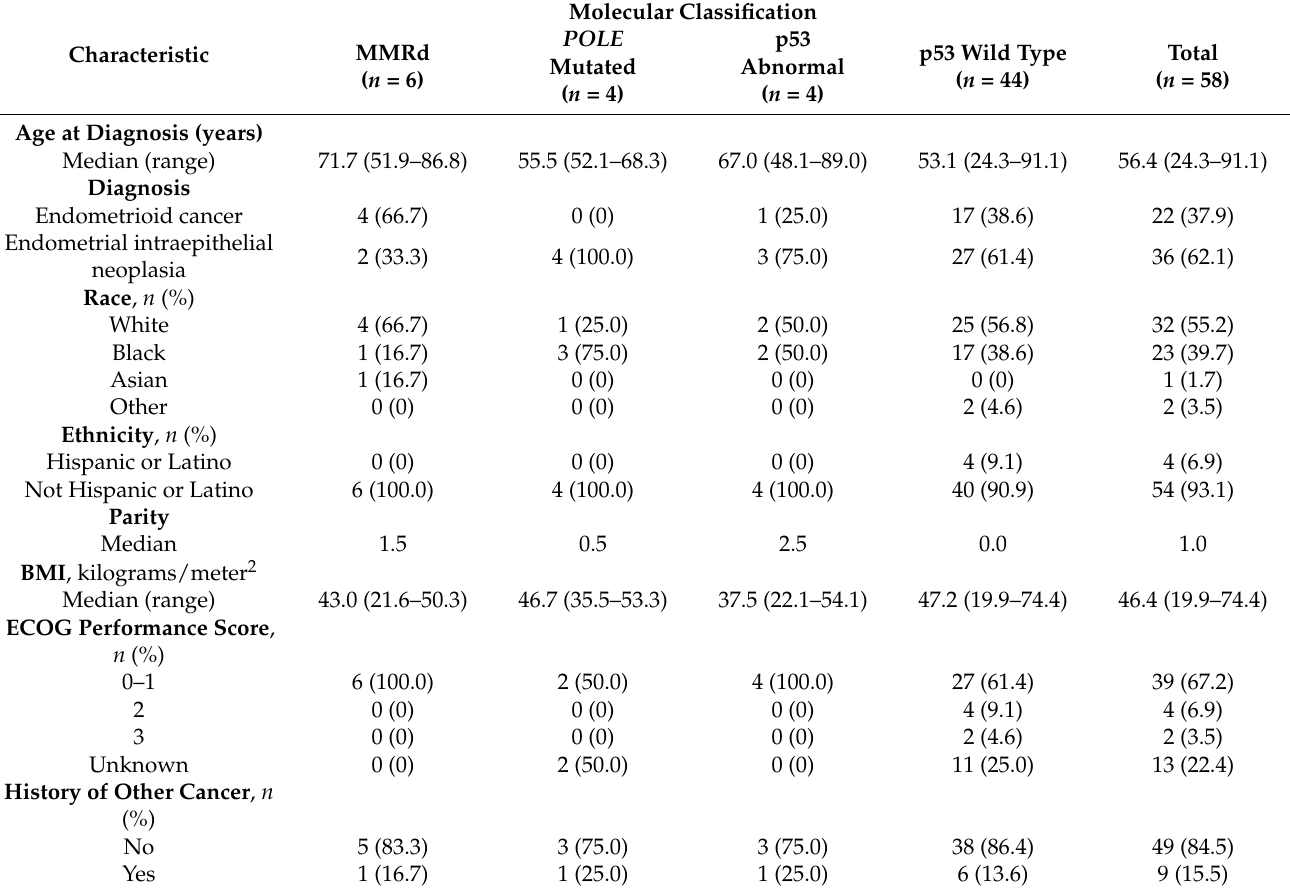
Table 1. Patient characteristics by molecular